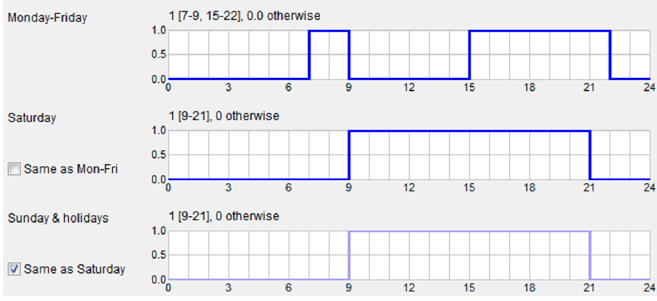
Figure 10. Scheduled internal loads of players.